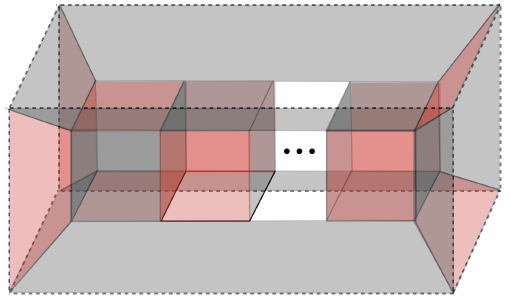
Figure 28 . A multi-cube model. Internal bricks are separated by chiral faces. The 90 ◦ between the external faces at the two endpoints of this figure corresponds to having an even number of